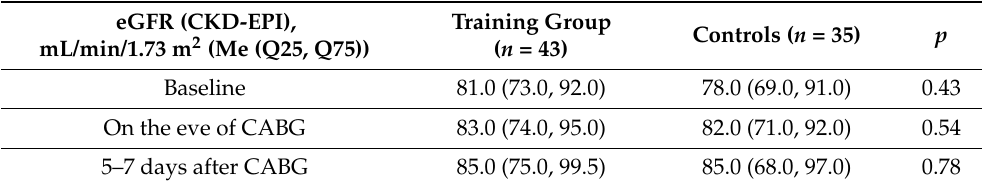
Table 4. Estimates of glomerular filtration rate in the perioperative period for patients undergoing elective coronary bypass surgery according to the approach to